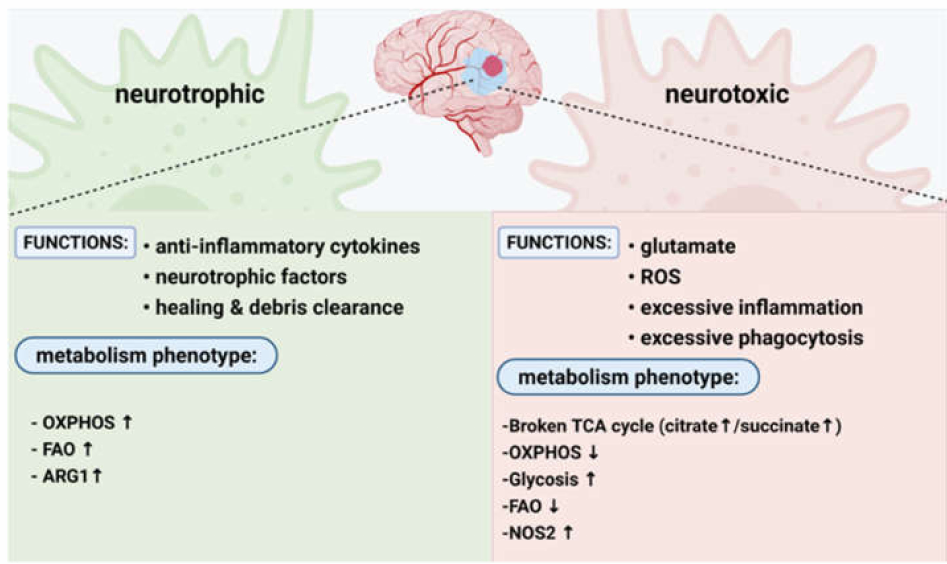
Figure 1. The functional and metabolic phenotype of ischemic core microglia/macrophages. Neu- roprotective macrophages: (1) secretion anti-inflammatory factors, (2) secretion of neuroprotec- tive/growth factors, and (3) tissue repair and tissue debris removal. Oxidative phosphoryla- tion increases, fatty acid oxidation increases, and arginine metabolism. Neurotoxic macrophages: (1) neuronal damage caused by the excitotoxicity of glutamate released by neurons and microglia; (2) reactive oxygen species (ROS) on proteins, phospholipids, and neurons; nucleic acid is chemically modified; (3) neuronal damage caused by excessive inflammation related to local and systemic immune responses; (4) neuronal cell death due to excessive phagocytosis of immune cells. The kinetic energy of the tricarboxylic acid cycle is insufficient (causing the accumulation of citric acid and succinic acid), therefore, the level of oxidative phosphorylation, the level of glycolysis, the metabolism of arginine, which is characterized by the formation of nitric oxide, and the oxidation of fatty acids are